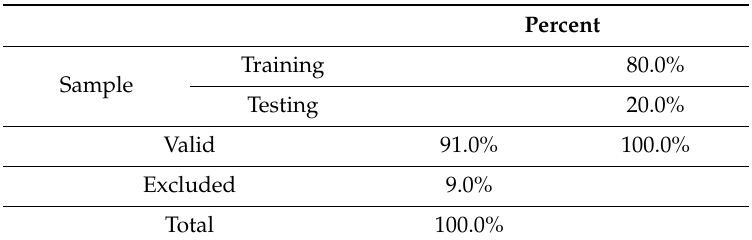
Table 1. Case processing